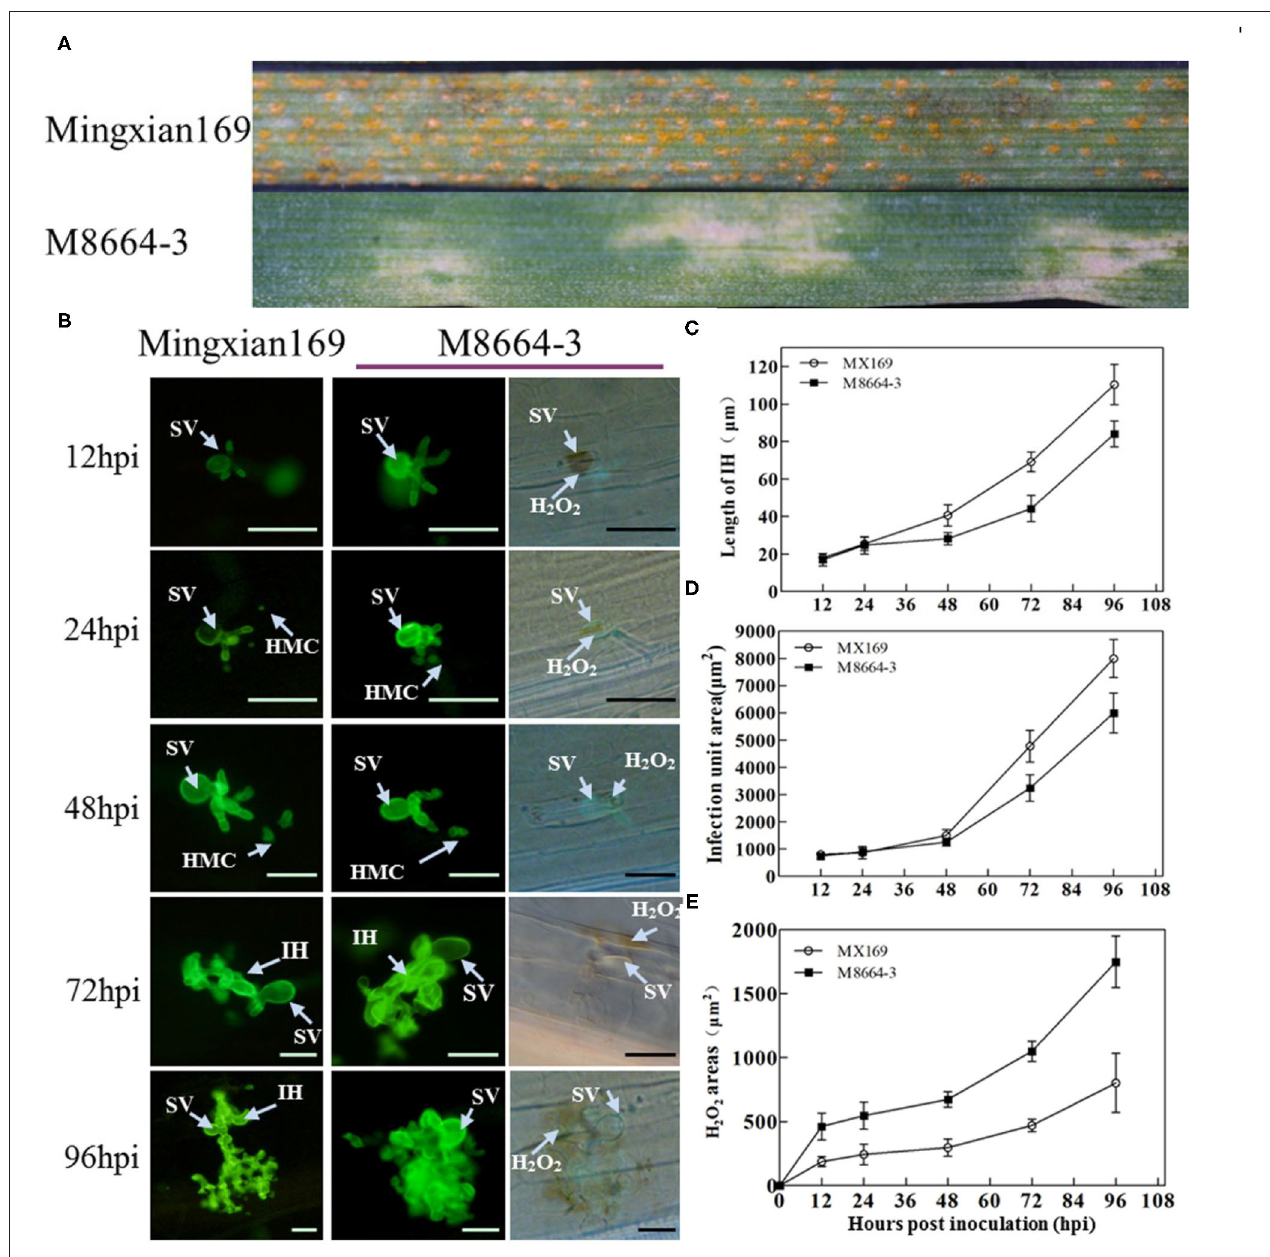
FIGURE 1 | (A) Symptoms of wheat- Leymusmollis introgression line M8664-3 and susceptible control cultivar Mingxian169 after inoculation with Puccinia striiformis f. sp. tritici ( Pst ) race CYR33. (B) Wheat germ agglutinin (WGA) was used to stain the leaves to visualize pathogens. SV, substomatal vesicle; IH, infection hyphae; HMC, haustorial mother cell; ROS, reactive oxygen species. (C) Hyphal lengths were measured at different hpi. (D) Infection unit area at different hpi. (E) H 2 O 2 area at different hpi. Error bars represent the standard deviations of three independent samples. Bar, 50 µ m. TraesCS4A01G305600 (Leucine-rich repeat receptor-like protein kinase family protein), TraesCS4A01G319000 (PGR5-like protein 1A, chloroplastic), TraesCS4A01G319300